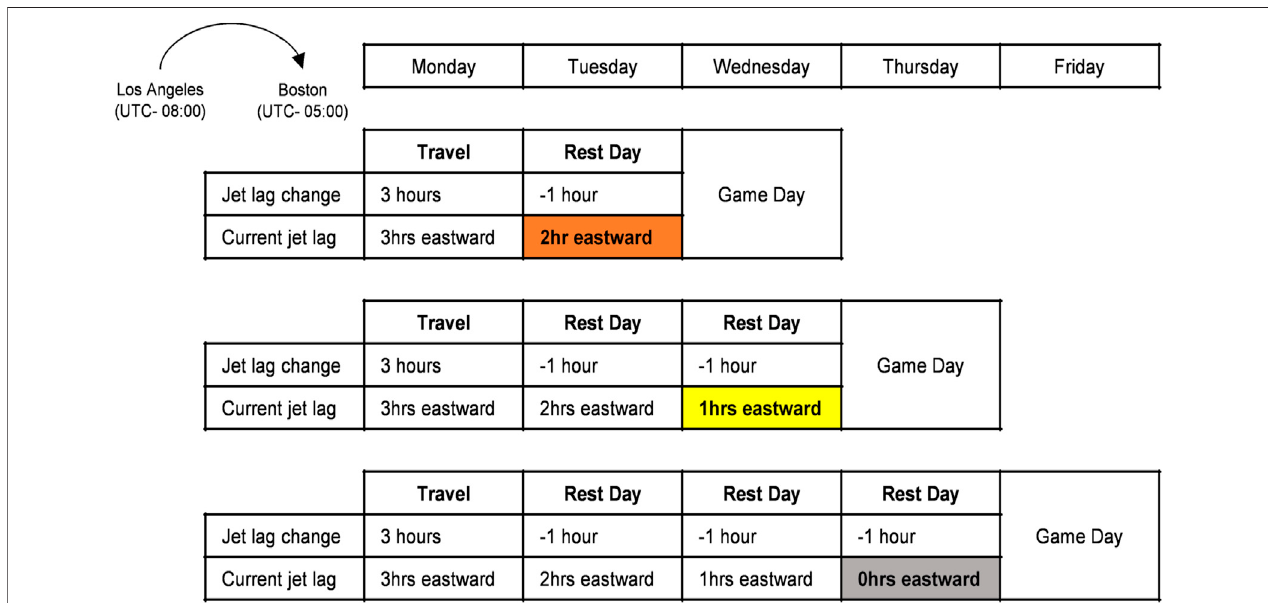
FIGURE 1 | A visual representation of how jet lag was estimated based on game dates and locations. For example, Team A travels from Los Angeles (PST; UTC − 08:00)toBoston(EST;UTC − 05:00)onMonday,hasarestdayonTuesday,thenplaysTeamBonWednesday.TeamAwouldbeassignedavalueof2 heastward